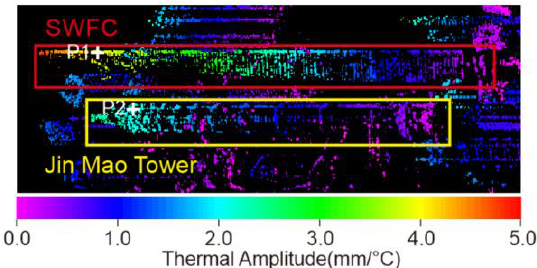
Figure 4. Thermal amplitude map of the two skyscrapers in Shanghai Lujiazui Zone estimated by theTomo-PSInSAR. The red rectangle in the top figure denotes the SWFC, and the yellow rectangle denotes the Jin Mao Tower.